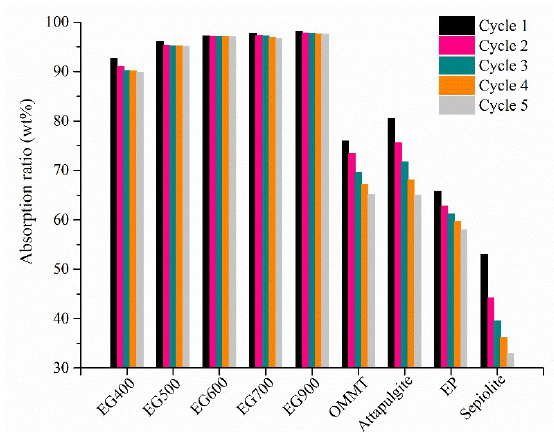
Figure 1. Absorption ratios of different inorganic porous skeletons to stearic acid during five cycles.